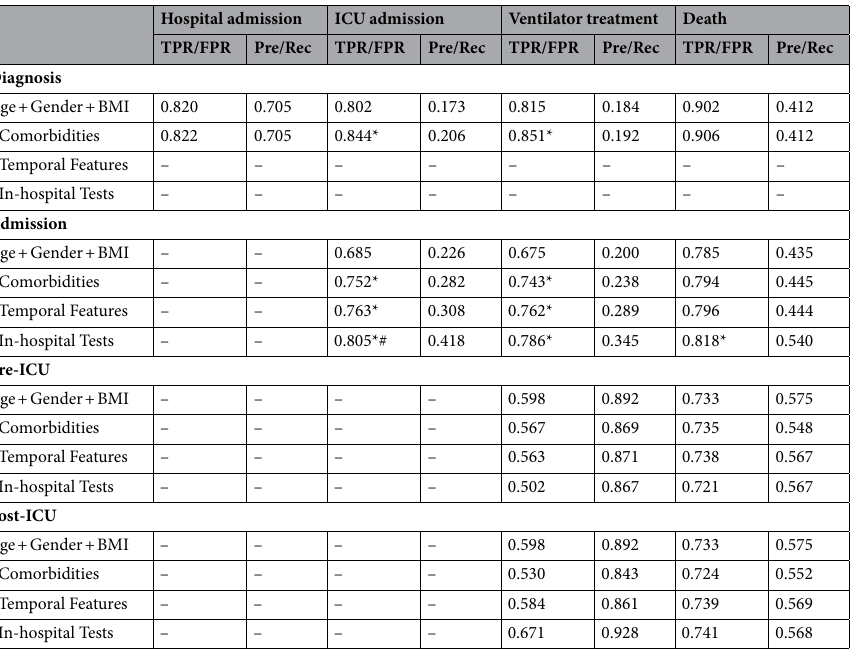
Table 3. Main results from the prediction models. Predictions were performed with data available from four different time frames in the patient disease trajectories (left column): On diagnosis (Diagnoses model), On hospital admission and 12-h into admission (Admission model), 12 h leading up to Intensive Care Unit (ICU) admission (Pre-ICU model) and 12 h after ICU admission (post-ICU model). Models were trained to predict risk of hospital admission, ICU admission, ventilator treatment and death (top row). All models were trained with incremental data, starting with age, gender and Body Mass Index, then adding comorbidity information, temporal features (e.g. vital signs) and finally by adding hospital laboratory tests where applicable. Please see supplementary tables S1 and S2 for data definitions. Performance metrics are presented as the Receiver Operating Characteristics Area Under the Curve (ROC-AUC) for True/False positive rates (TPR/ FPR) and Precision/Recall (Pre/Rec). *Model is significantly ( p < 0.01) better than the base prediction model (Age + gender + Body Mass Index, BMI). # Model is significantly ( p < 0.01) better than the comorbidities model. § Model is significantly ( p < 0.01) better than the temporal model. --: Insufficient data available at the time point, or prediction irrelevant (e.g. predicting hospital admission for patients already in the